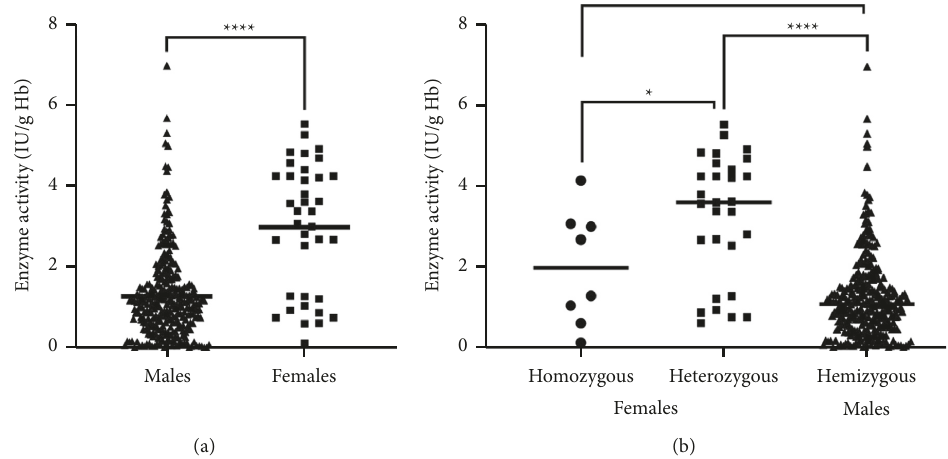
Figure 1: Comparative distribution of G6PD activity by genders and genotypes. Each dot represents the G6PD enzyme activity of each subject. (a) G6PD activities between males and females. (b) G6PD activities among genotypes in both males and